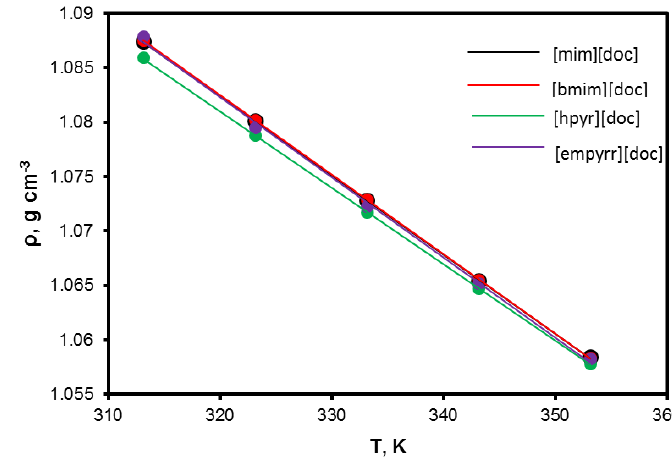
Figure 3. Density of the ionic liquids as a function of temperature.